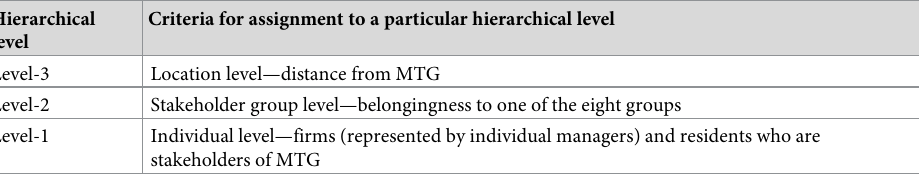
Table 1. Characteristics at each hierarchical level of the study, adopted from Woltman et al. [73]. Hierarchical